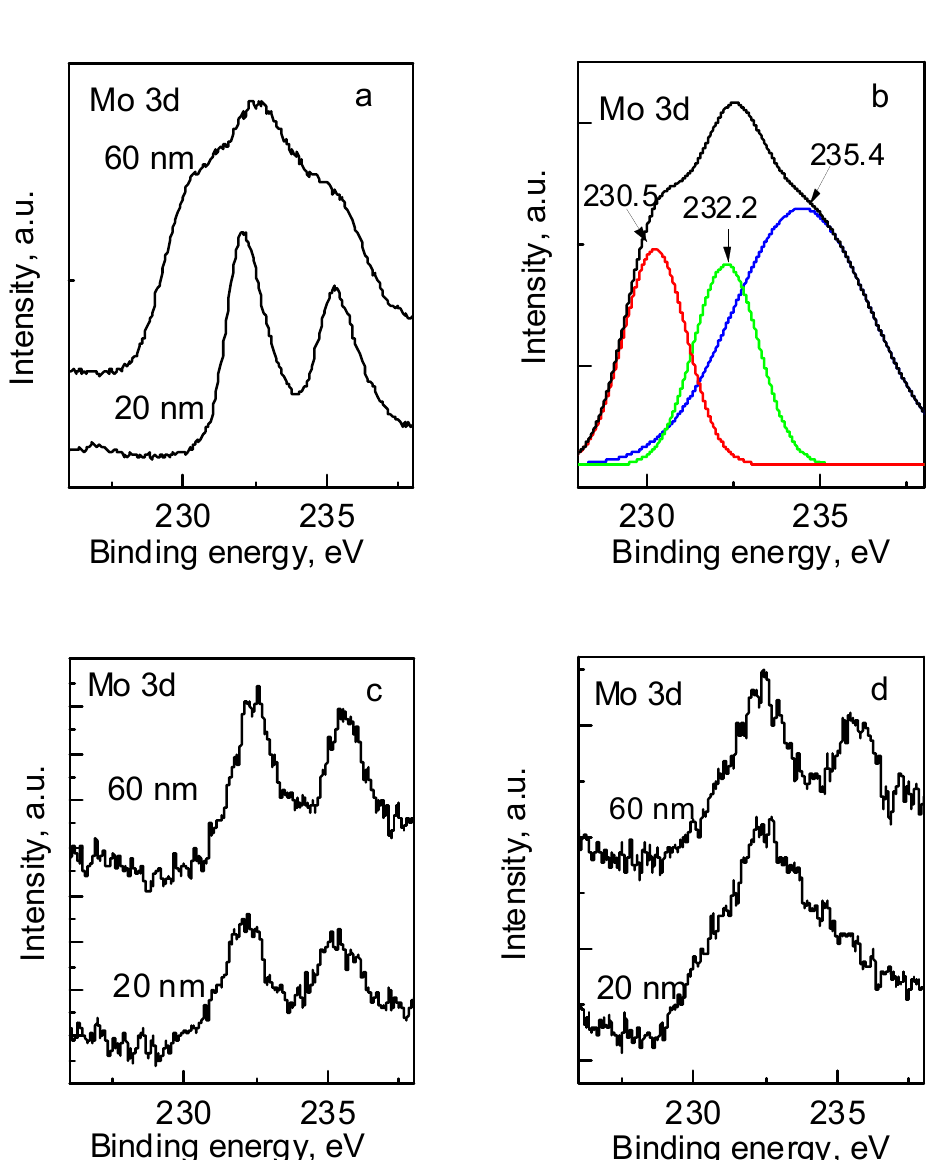
Figure 4. XPS spectra of Mo 3d for Fe/P-Mo ( a , b ), Fe/P-Mo-Ce1 ( c ) and Fe/Mo-Ce2 ( d ) coatings at 20 and 60 nm depth. ( b ) Deconvolution of Mo 3d peak of Fe/P-Mo sample at 60 nm depth.